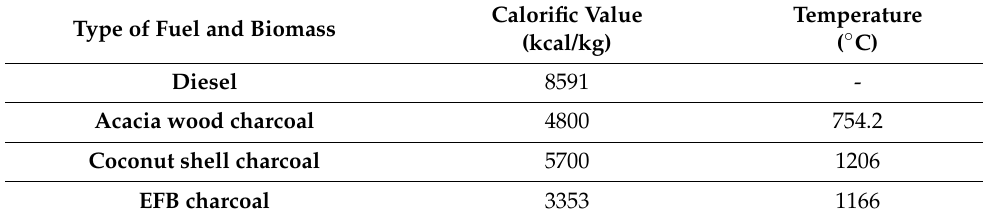
Table 2. Comparison of calorific value and